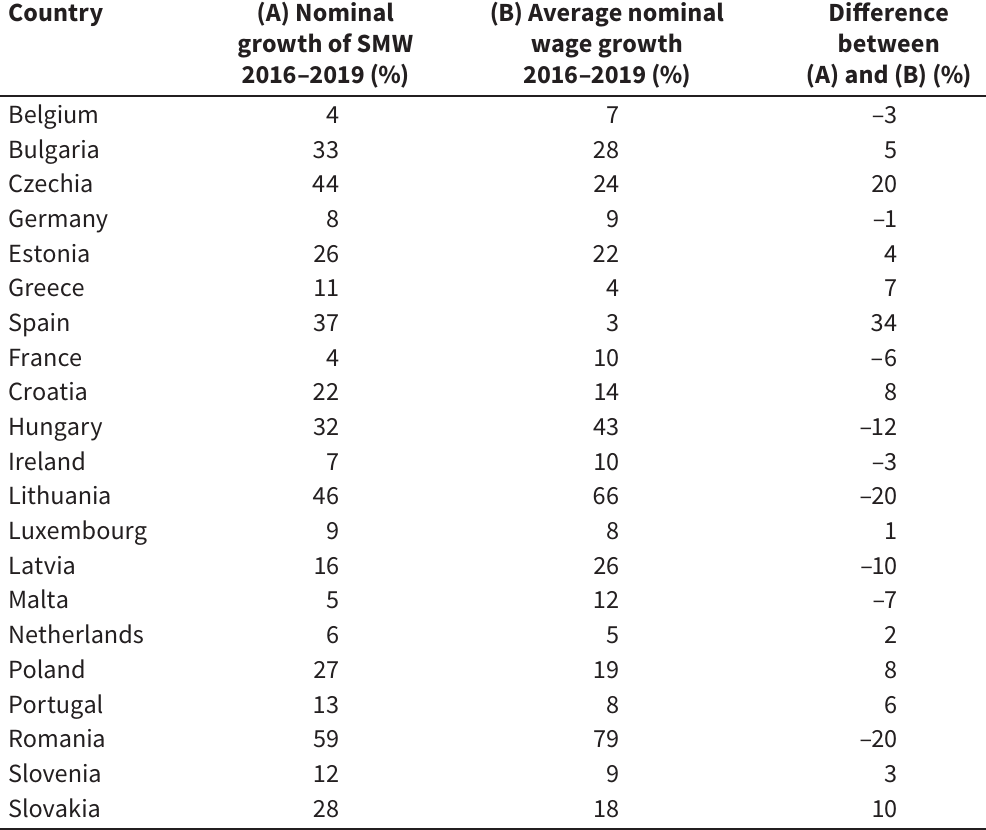
Difference in growth between SMWs and average wages from 2016 to 2019